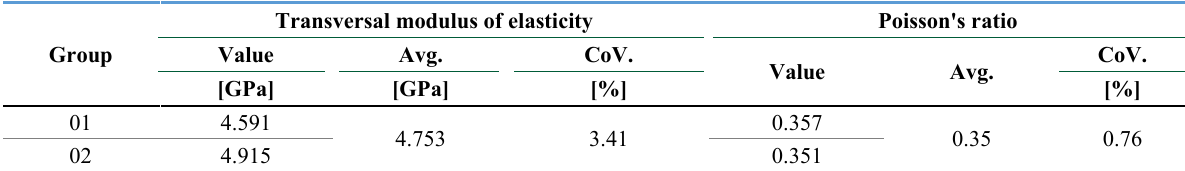
Table 4. Transversal modulus of elasticity and Poisson’s ratio for GFRP plates Transversal modulus of elasticity Poisson's ratio Value Avg. CoV. Group